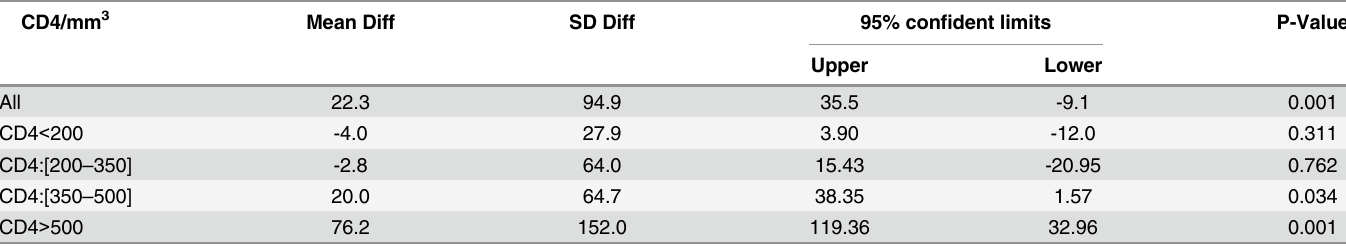
Table 1. Comparison of the mean difference between the CD4 PIMA TM Alere and BD FACSCount TM CD4 measurements. CD4/mm